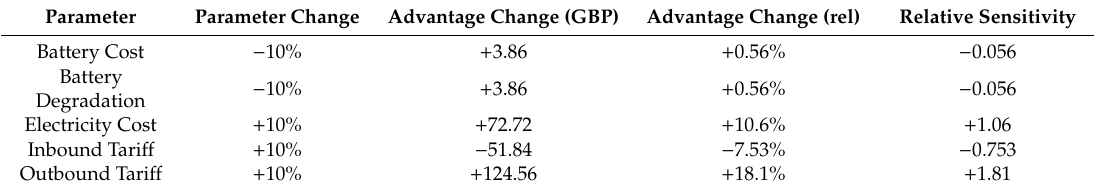
Table 5. Results of a sensitivity study of the V2G results with respect to key factors.